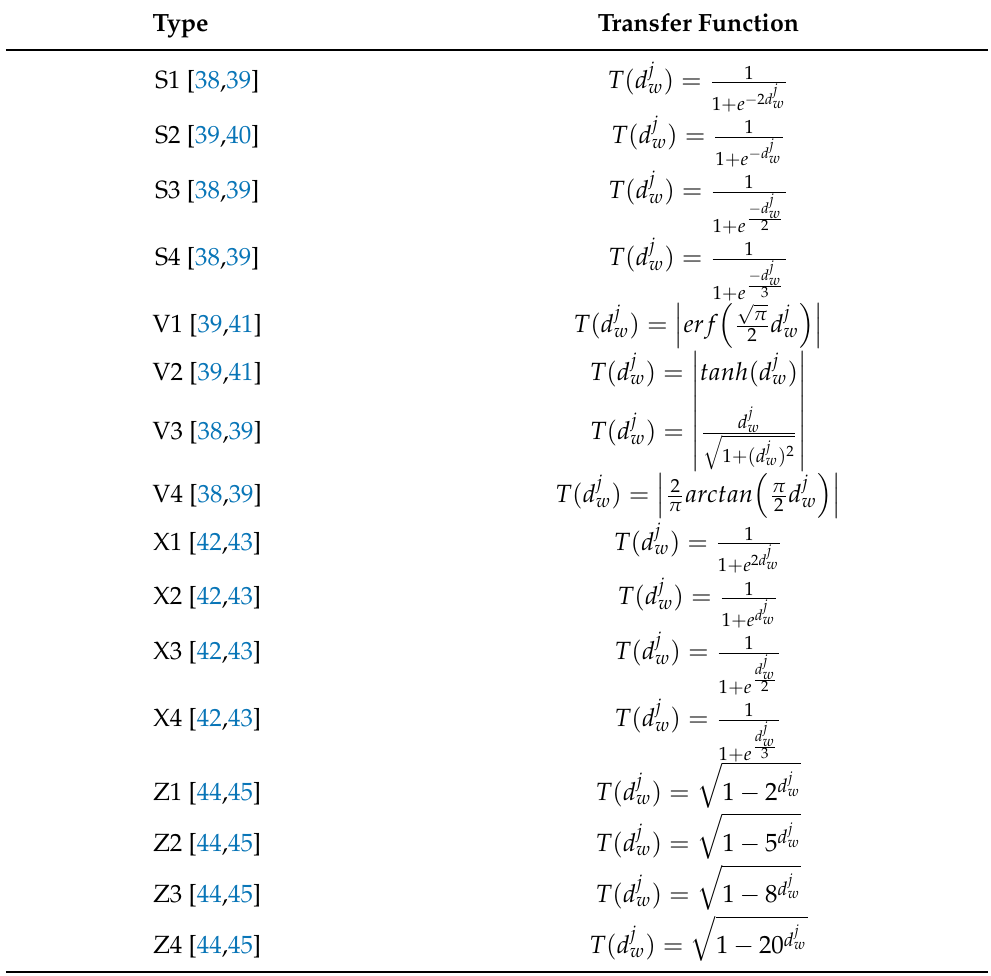
Table 1. Transfer